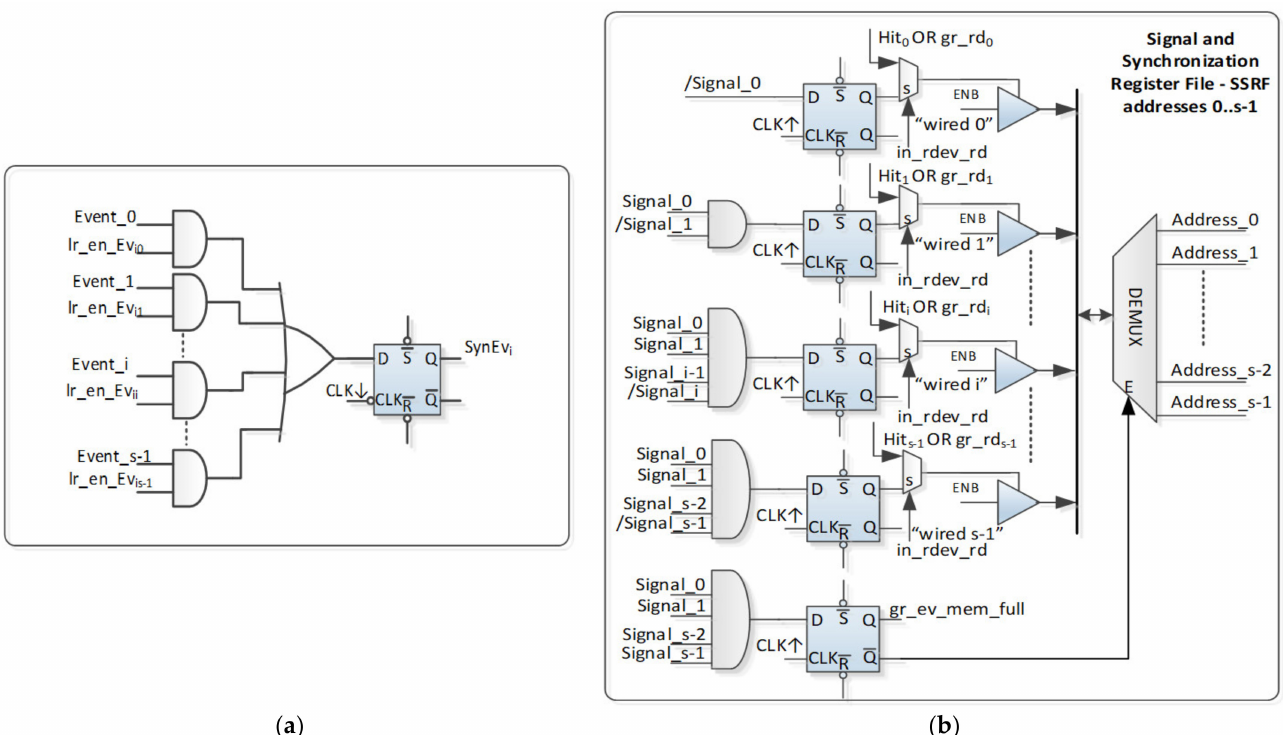
Figure 4. ( a ) nHSE event validation logic; ( b ) automatic address generator for the first free event based on